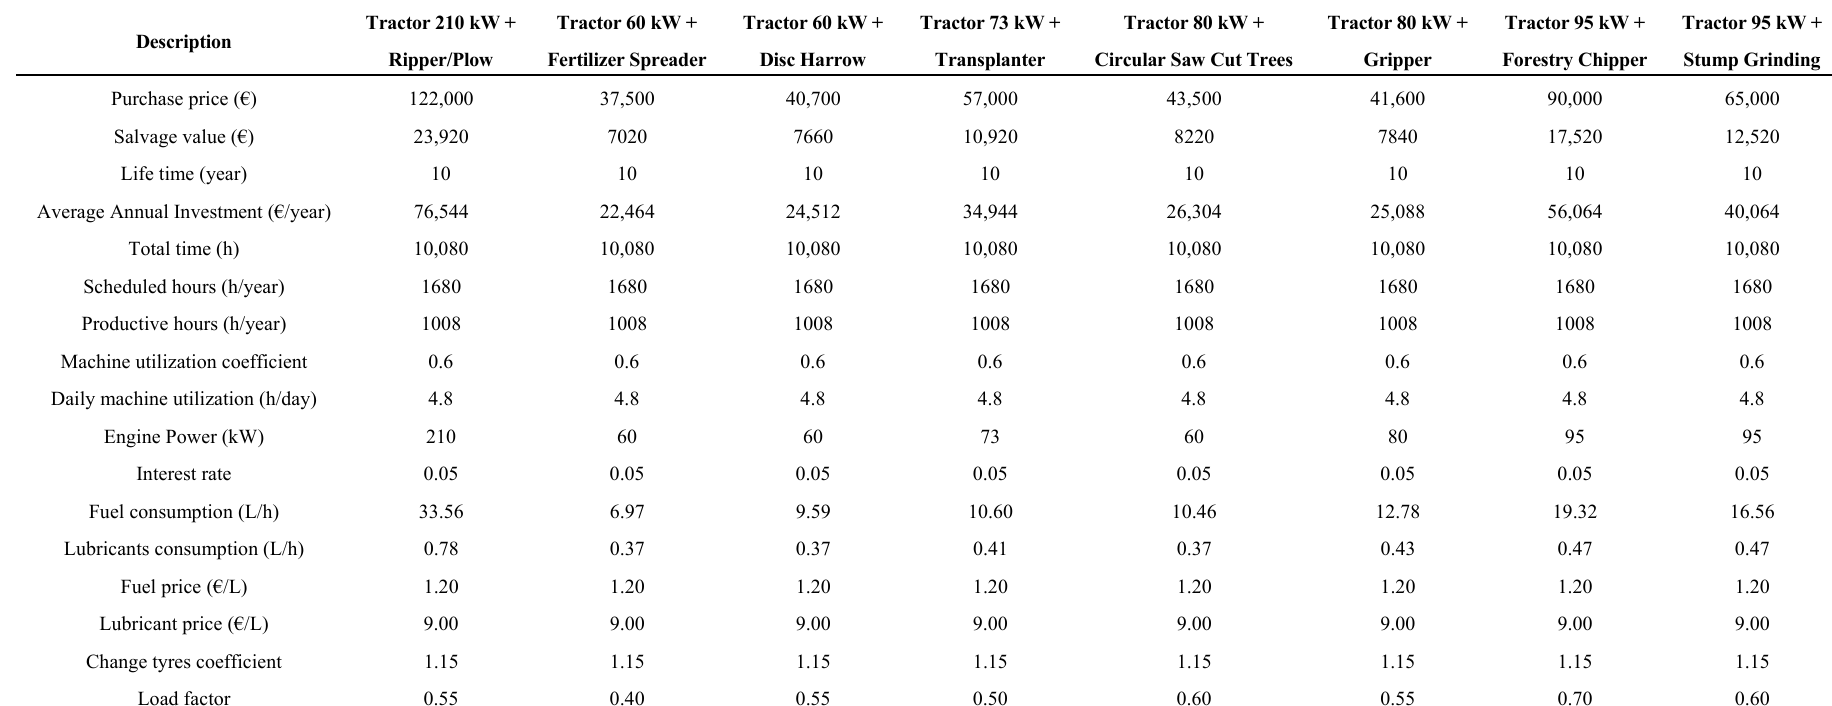
Table 3. Technical elements for the calculation of the machine